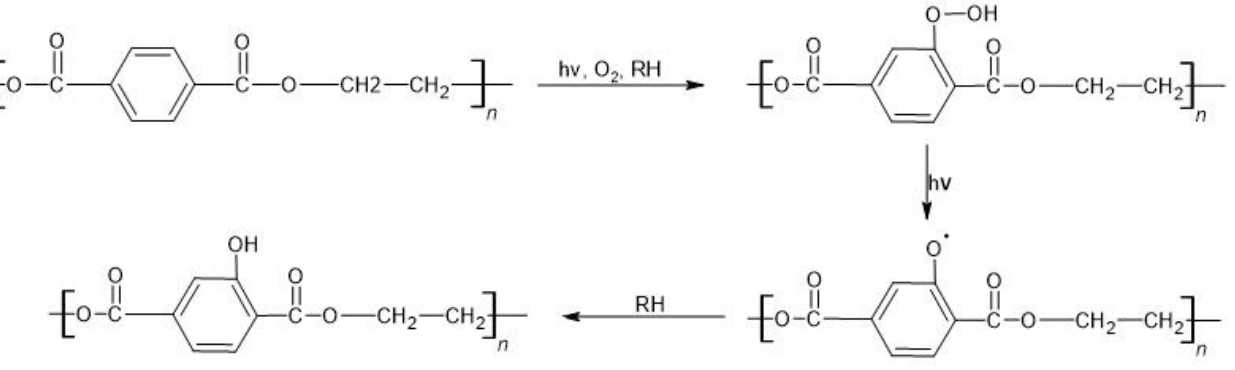
Figure 4. Photodegradation of PET (hν — to add energy via photons, RH —inclusions). Polystyrene